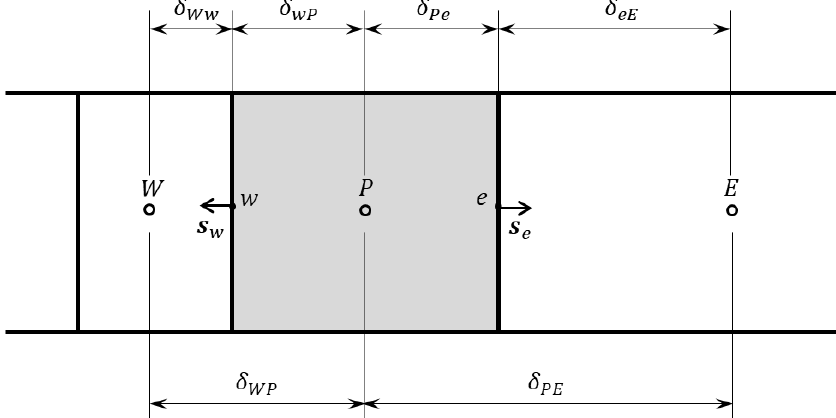
Figure 3. Three neighboring CVs with compass notation ( P —central cell center, W —west cell center, E —east cell center).